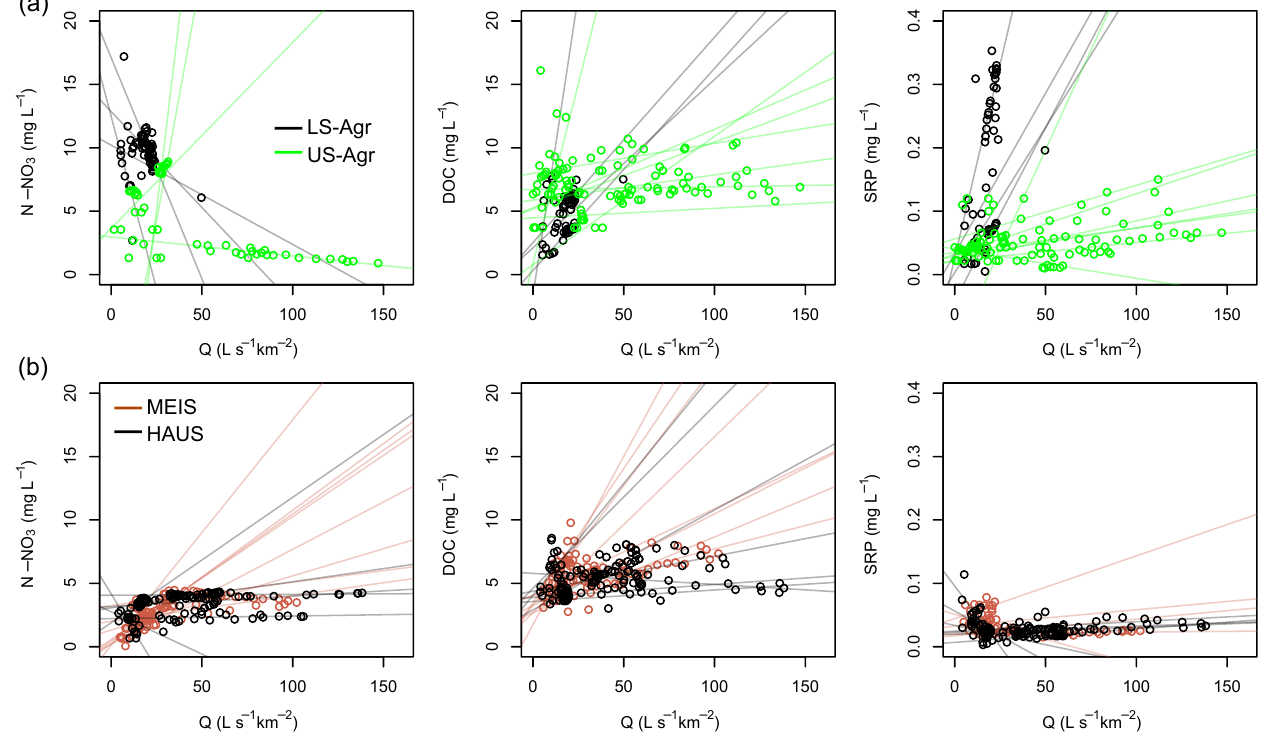
Figure 5. Concentration–discharge relationships during storm events in (a) two headwater catchments (LS-Agr, n = 4; US-Agr, n = 8) and in (b) two downstream reaches (MEIS, n = 8; HAUS, n = 8) for three solutes: nitrate-N, dissolved organic carbon (DOC) and soluble reactive phosphorus (SRP). Linear regression models were fitted to each event to quantify the proportion of events with a dilution (negative slope) or an accretion pattern (positive